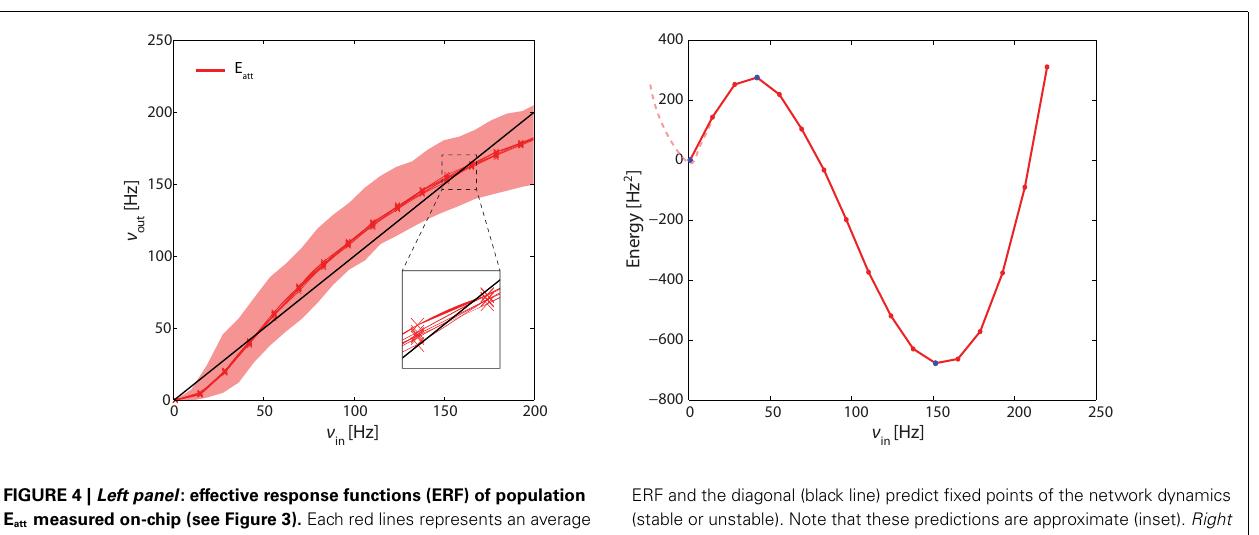
FIGURE 5 | Firing rates of E att and E bkg in response to multiple input transients (“kicks,” central figure). Excitatory (inhibitory) transients are created by square-pulse increments of E1 AER (I AER ) activity.The timing of input transients is illustrated beneath the central figure: 0.5 and 1.5s mark the onset of sub-threshold ( ν E1 = 34Hz) and supra-threshold ( ν E1 = 67, 84, or 115Hz) excitatory “kicks,” 3 and 4s that of sub- and supra-threshold inhibitory “kicks.” Sub-threshold “kicks” merely modulate activity of the current meta-stable state. Supra-threshold “kicks” additionally trigger a transition to